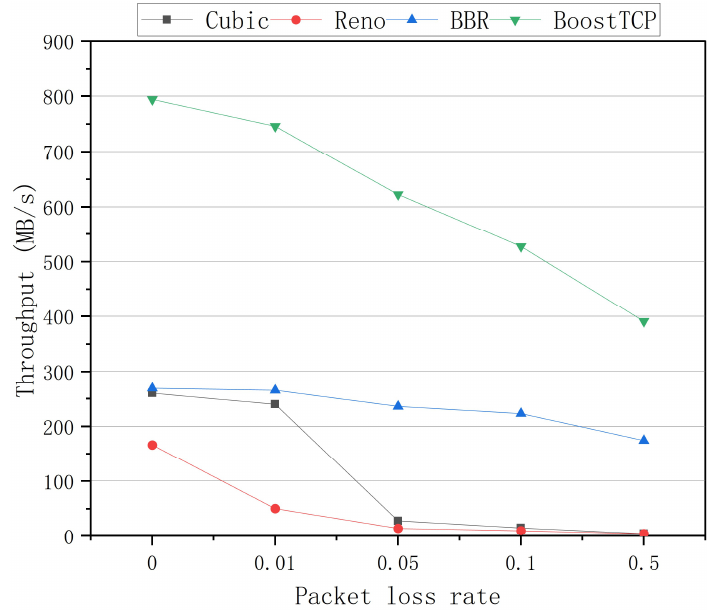
Figure 8. The throughput curves of the four congestion control algorithms as a function of the packet loss rate at a network delay of 80 ms.